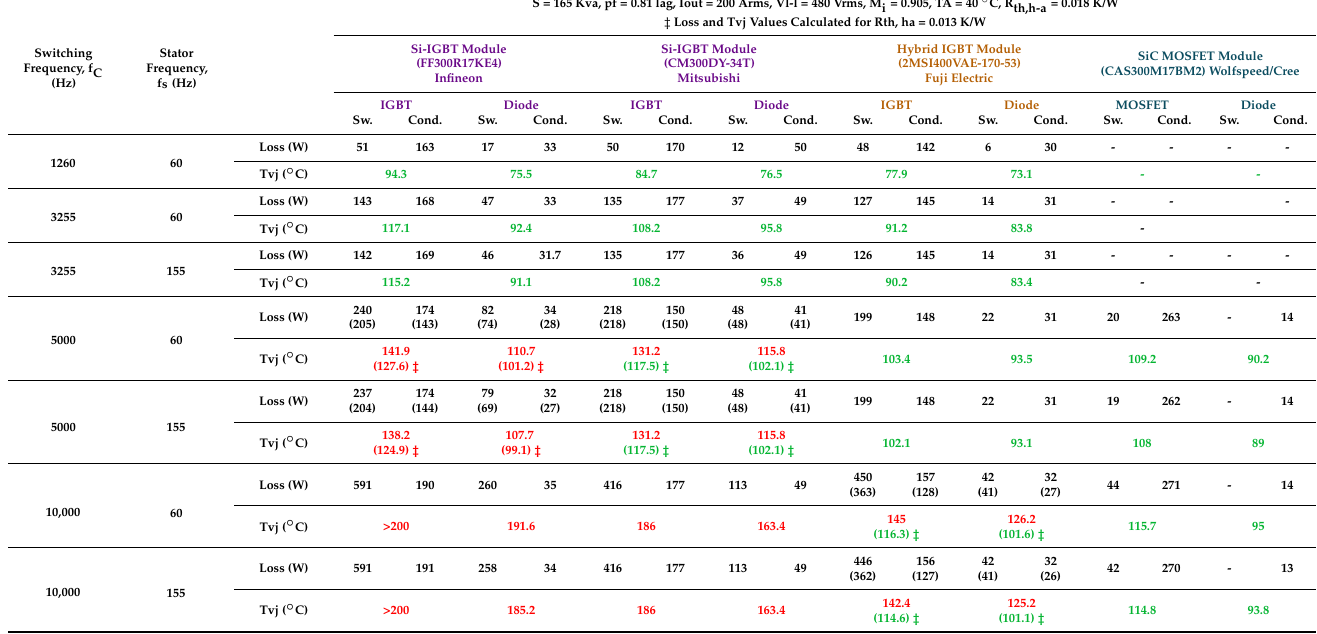
Table 5. Thermal performance of SiC power MOSFET modules in a traction converter as a function of carrier frequency and stator frequency in comparison with those of hybrid and Si-IGBT